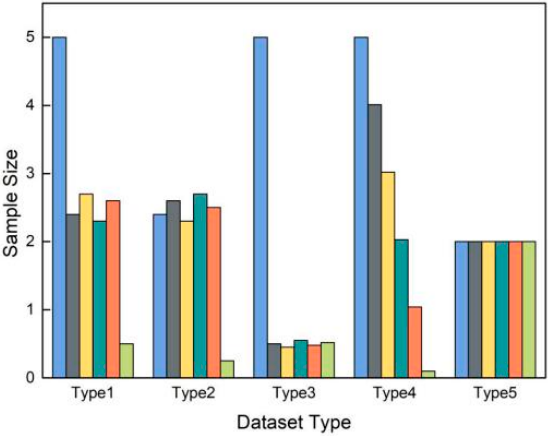
Figure 1. The types of datasets in the actual network environment.